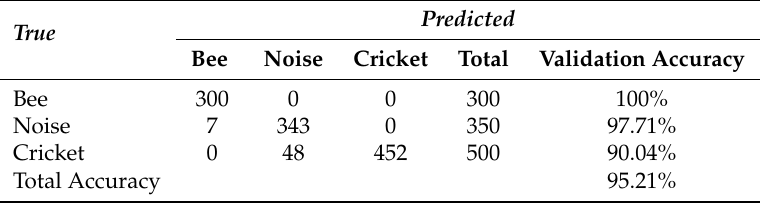
Table 11. Confusion matrix for RawConvNet with receptive field size n = 80 on BUZZ1 validation dataset.